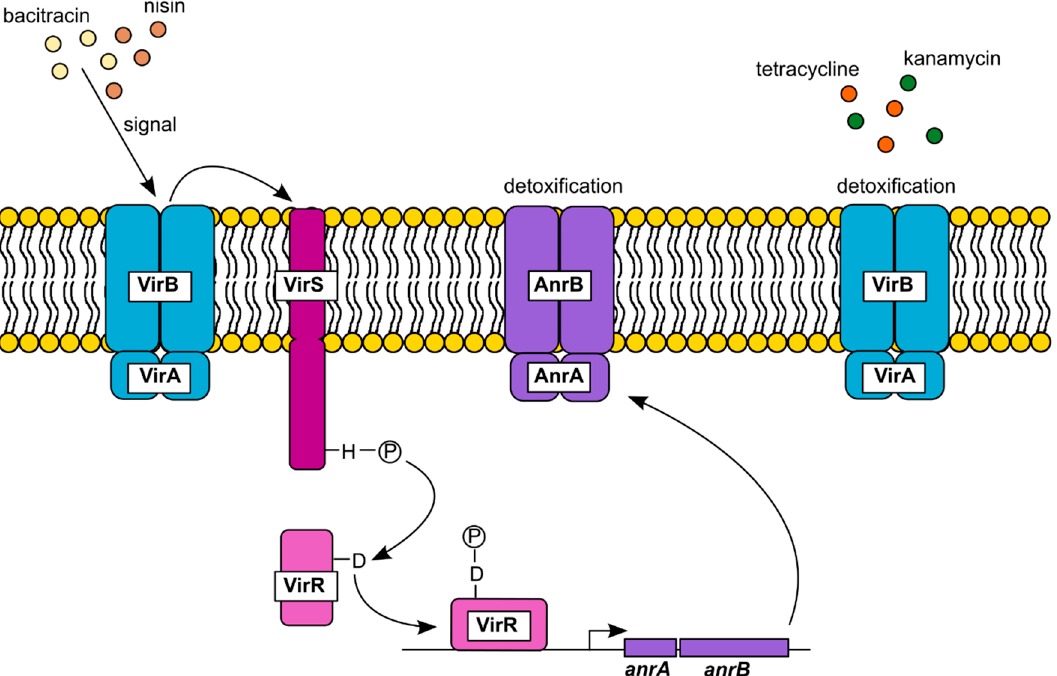
Figure 1. The VirAB-VirRS-AnrAB resistance module of L. monocytogenes EGD-e. The ABC transporter VirAB senses the presence of bacitracin, nisin and a number of β -lactam antibiotics. This leads to activation of the intramembrane-sensing histidine kinase VirS, which subsequently phosphorylates the response regulator VirR [46,47]. VirR binds to the VirR consensus sequence present in the promoter region of anrAB and induces the expression of both genes [46,51]. The ABC transporter AnrAB detoxifies bacitracin and nisin by a so far unknown mechanism. The detoxification of kanamycin and tetracycline by VirAB occurs in a VirRS-independent manner [46].